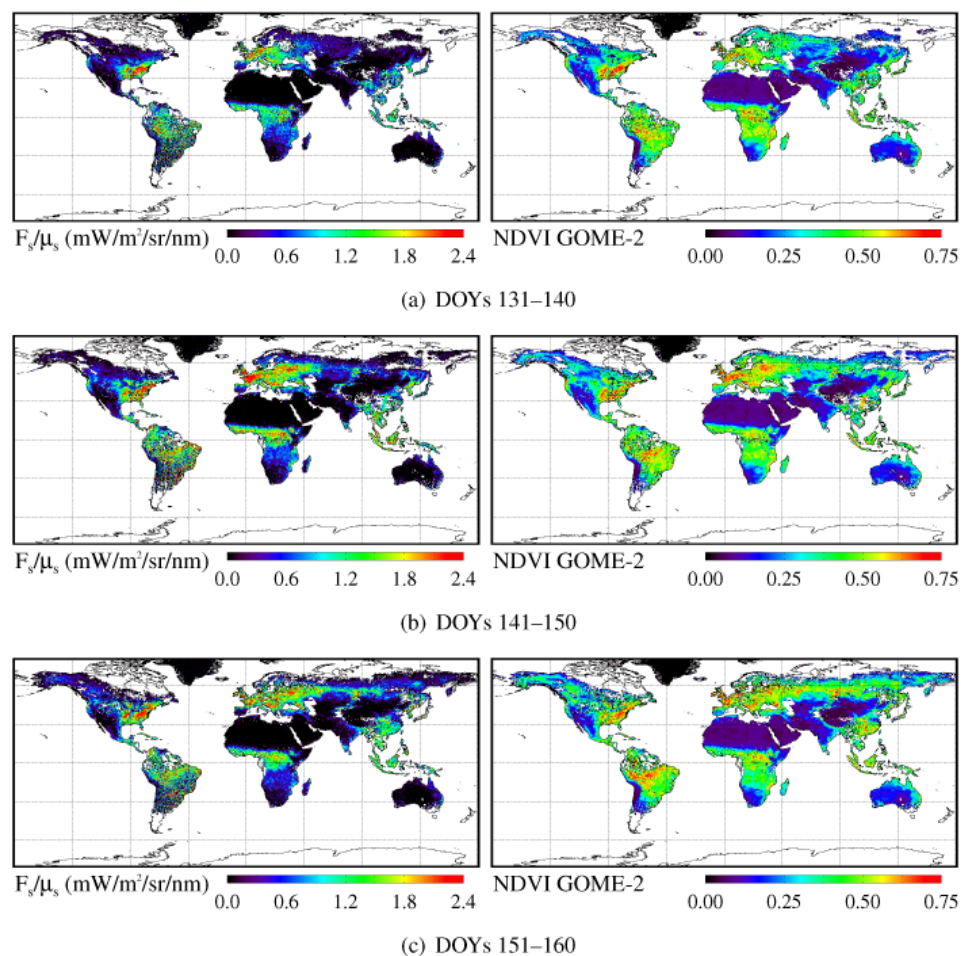
Fig. 17. Ten-day composites of F s and NDVI derived from GOME-2 data in 0.5 × 0.5 ◦ grid cells between day of year (DOY) 131 and 160 of 2009. Fluorescence is normalized by the cosine of the sun zenith angle ( µ s ) in order to minimize the temporal and latitudinal dependence of fluorescence on incoming at-surface photosynthetically active